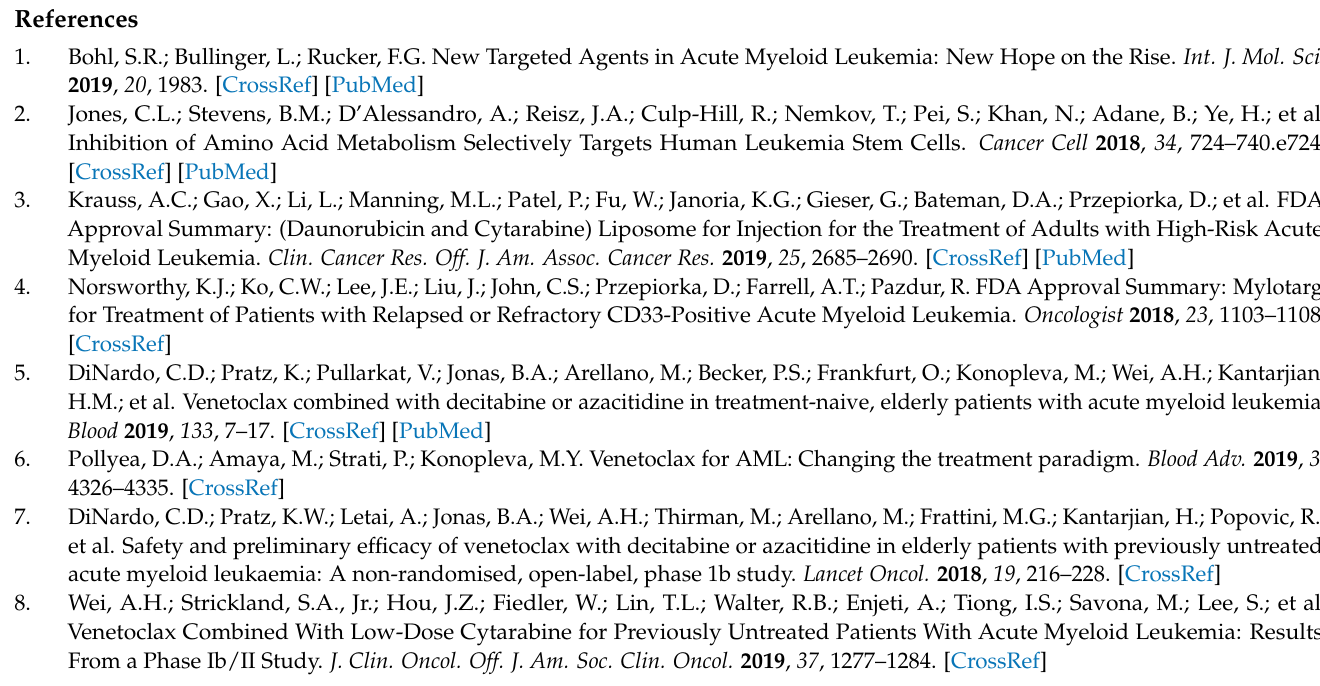
Table S1: Patient characteristics of primary AML samples; Table S2: Target sequences for siRNAs; Table S3: Primer sequences used for ChiP and qPCR analysis; Table S4: List of antibodies used for ChiP, IF, IP and IB analysis; Figure S1: Effects of 8-Cl-Ado plus VEN on mitochondria metabolism. Figure S2: Effects of 8-Cl-Ado plus VEN on mitochondria membrane potential. File S1: Western blot raw data and quantification of Western